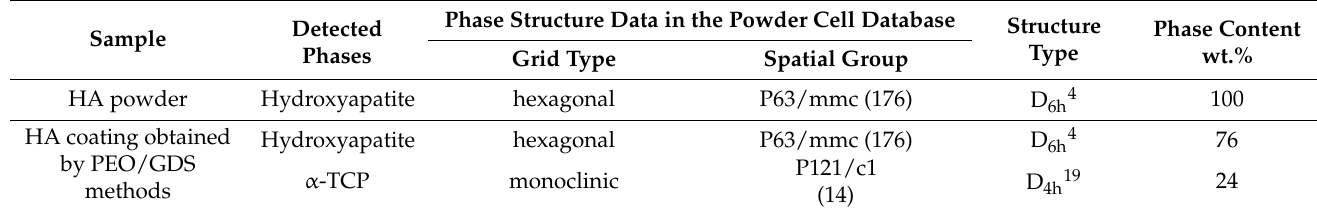
Table 4. X-ray phase analysis results.